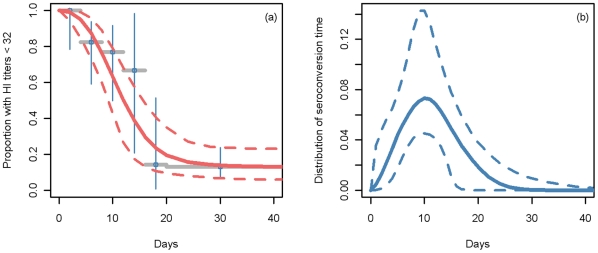
Estimation of the interval to seroconversion.a) Proportion of individuals with HI titer <32 by interval since symptom onset: blue lines and points show the proportion in four-day intervals with confidence intervals and the red curve show the fitted parametric inverse cumulative distributions with the 95% CI (credible intervals) and b) distribution of the time to seroconversion since symptoms with 95% CI.